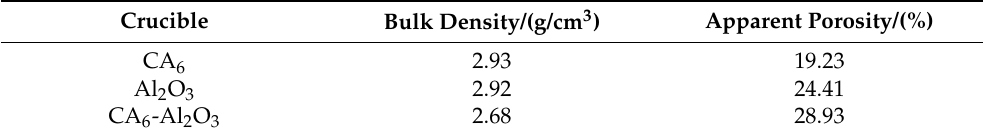
Table 1. The properties of the crucibles.